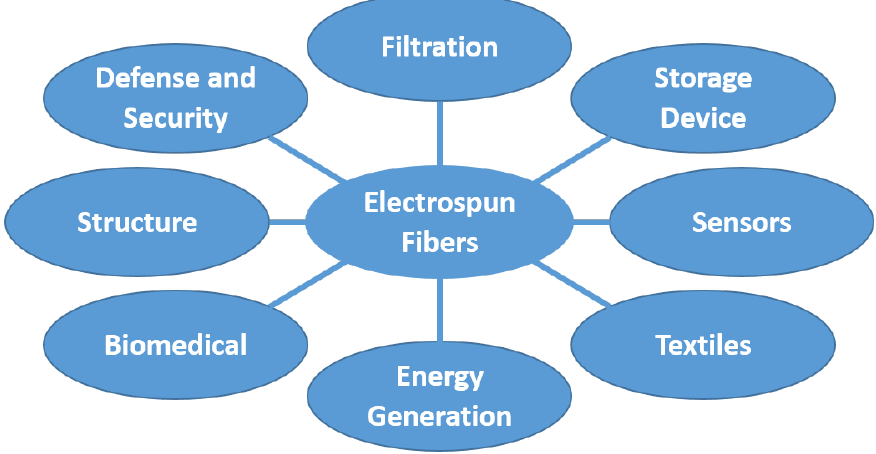
Figure 4. Applications of electrospun nanofibers.